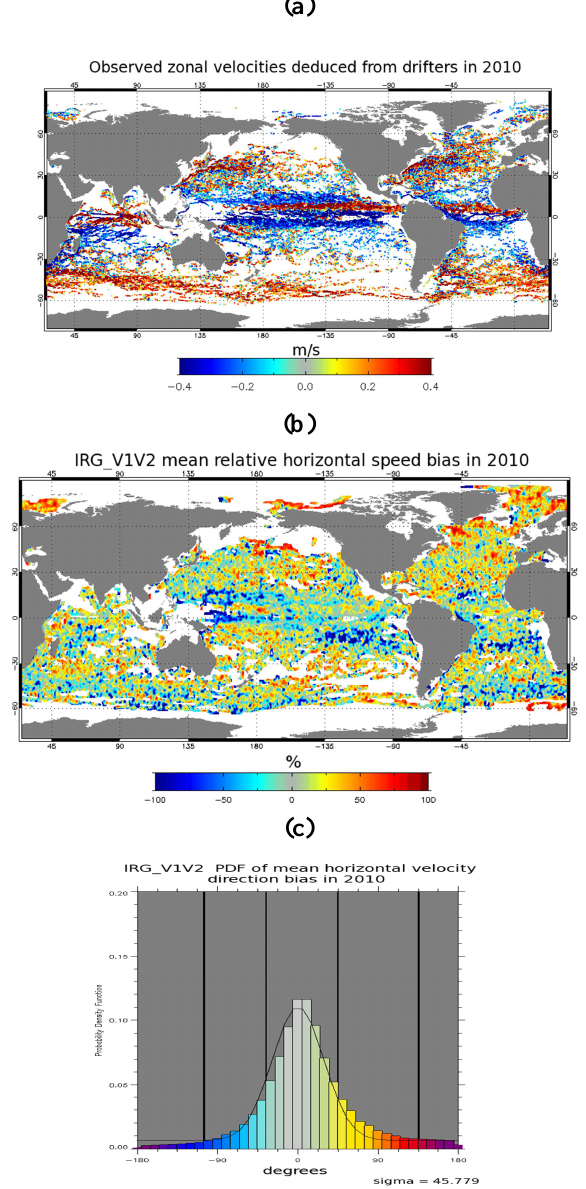
Fig. 14. (a) Zonal velocity observations (ms − 1 ) with “Merca- tor Oc´ean correction” (see text) deduced from all in situ Atlantic Oceanographic and Meteorological Laboratory drifters in 2010. (b) Mean relative horizontal speed bias (%) with respect to drifters in IRG V1V2. (c) Probability density function of the mean hori- zontal velocity direction bias (degrees) with respect to drifters in IRG V1V2. The Gaussian fit is superimposed, as well as the 1- sigma (thin lines) and 2-sigma interval (thick